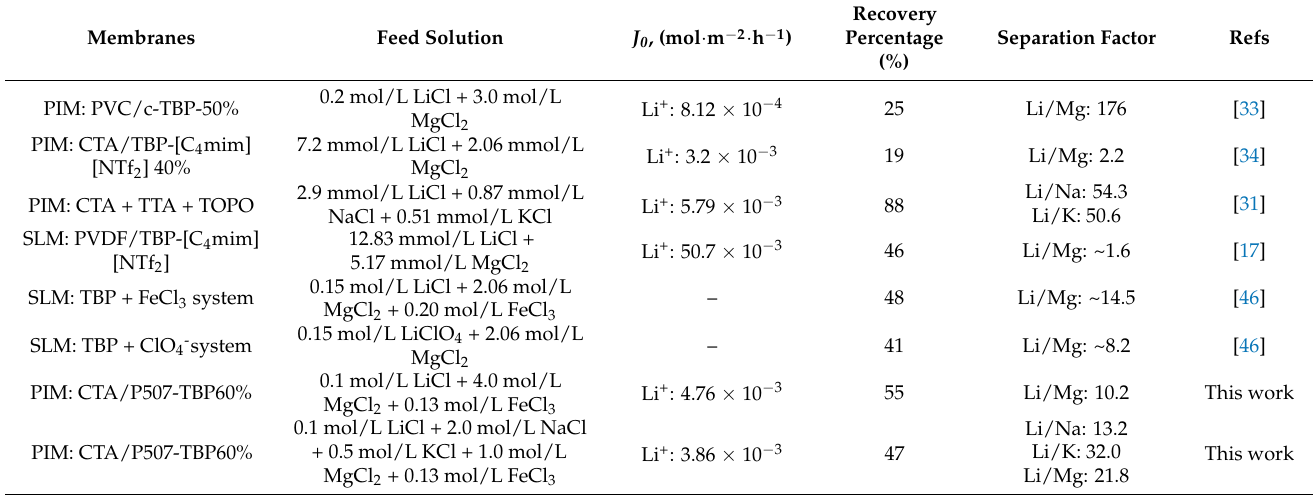
Table 2. Comparison of separation performance of different liquid membranes for Li + extraction.